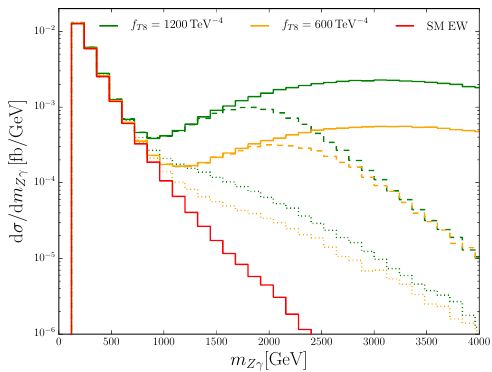
Figure 9 . Cross section of Z ‘ (cid:13)jj production in the SM and for di(cid:11)erent values of f T 8 . The line styles are as given in (cid:12)gure